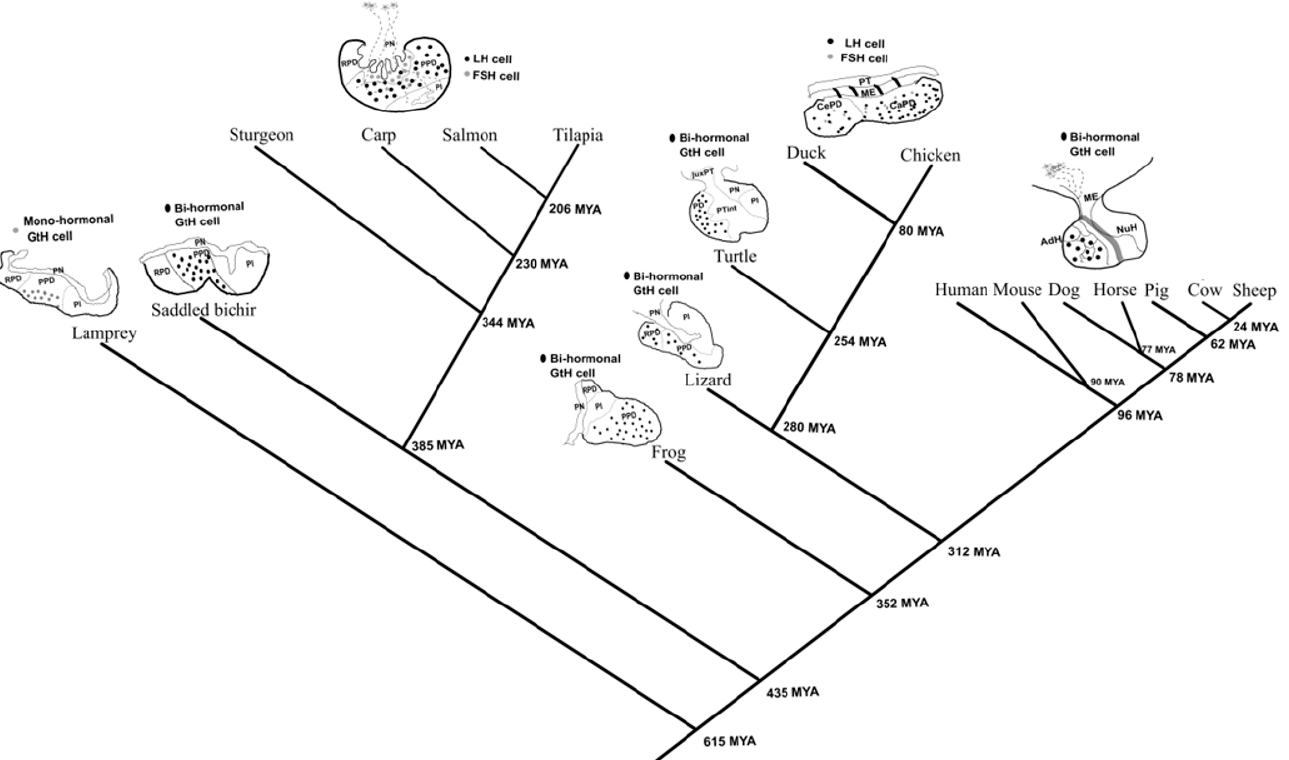
Figure 1. Taxonomic tree of representative vertebrate taxa showing differences in morphology and gonadotroph orga- nization. The distribution of FSH and/or LH cells in the vertebrate pituitary is either bi-hormonal (one cell expressing both gonadotropins), or mono-hormonal cells (two cells secreting each a different gonadotropic hormone). An exception is the proto-glycotrope expressing only one gonadotropic hormone that exists in lamprey. From the different taxa, only the teleost and avian exhibit the mono-hormonal cell morphology while mammals, reptiles, and amphibians exhibit the bi-hormonal morphology. The taxonomic tree was prepared using TIMETREE [25] and visualized with the pituitary diagrams using Inkscape. The evolutionary tree includes only organisms with known information regarding their GtH distribution in the pituitary. Information regarding each organism was obtained from: Mouse ( Mus musculus ) [26,27], dogs ( Canis lupus familiaris ) [28], pigs ( Sus scrofa domesticus ) [29], human ( Homo sapiens ) [30], sheep ( Ovis aries ) [31], horse ( Equus ferus caballus ) [32], cow ( Bos Taurus ) [33], lamprey ( Petromyzon marinus ) [34], Saddled bichir ( Polypterus endlicherii ) [35], tilapia ( Oreochromis niloticus ) [17], carp ( Cyprinus carpio ) [36], salmon ( Salmo salar ) [37], sturgeon ( Acipenser gueldenstaedtii ) [38], turtle ( Geoclemys reevesii ) [39], chicken ( Gallus gallus ) [24], duck ( Anas acuta ) [40], lizard ( Calotes versicolor ) [41], and frog ( Rana japonica ) [42]. Rostral pars distalis (RPD), proximal pars distalis (PPD), pars intermedia (PI), pars nervosa (PN), pars distalis (PD), juxtaneural pars tuberalis (juxPT), pars tuberalis interna (PTint), pars tuberalis (PT), median eminence (ME), cephalic pars distalis (CePD), caudal pars distalis (CaPD), adenohypophysis (AdH), neurohypophysis (NuH).